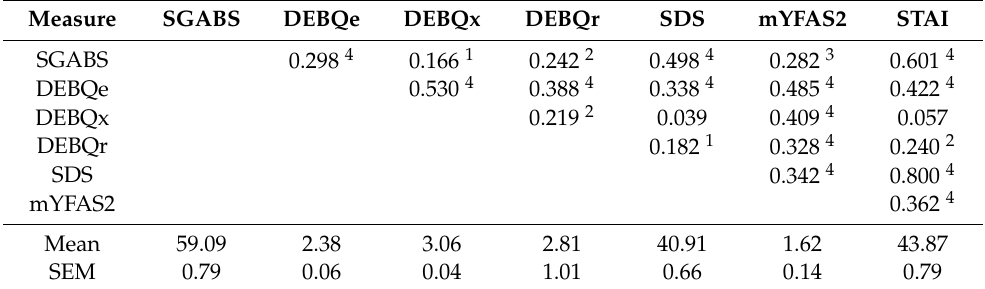
Table 1. Pearson correlation coe ffi cients among and descriptive statistics for the questionnaire measures. Measure SGABS DEBQe DEBQx DEBQr SDS mYFAS2 0.298 4